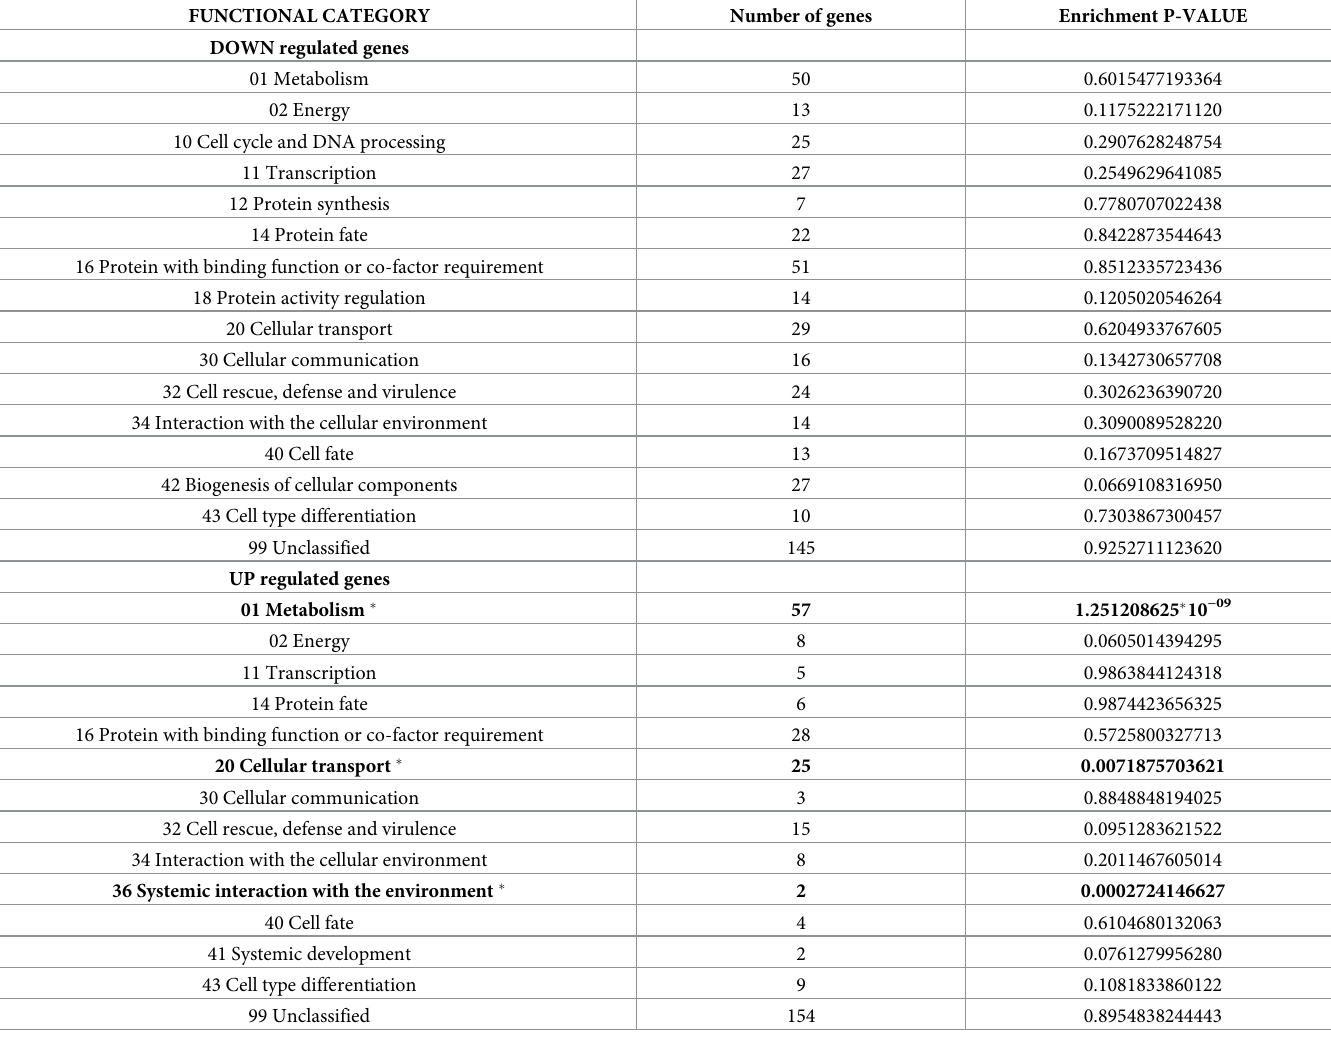
Table 2. Main functional category analysis (FunCat). FUNCTIONAL